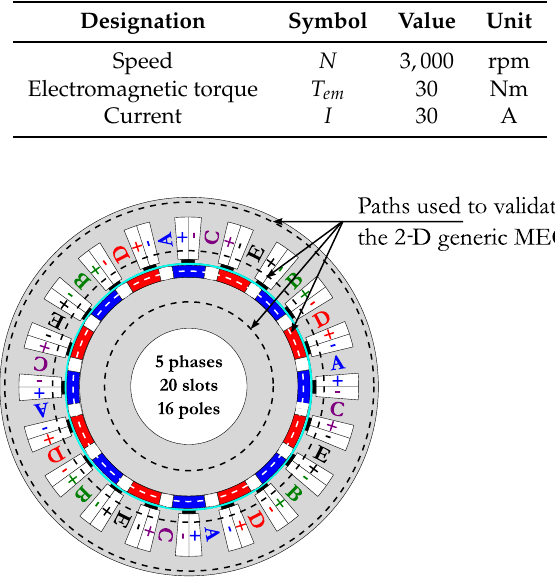
Figure 2. Description of the machine: Topology and winding distribution.